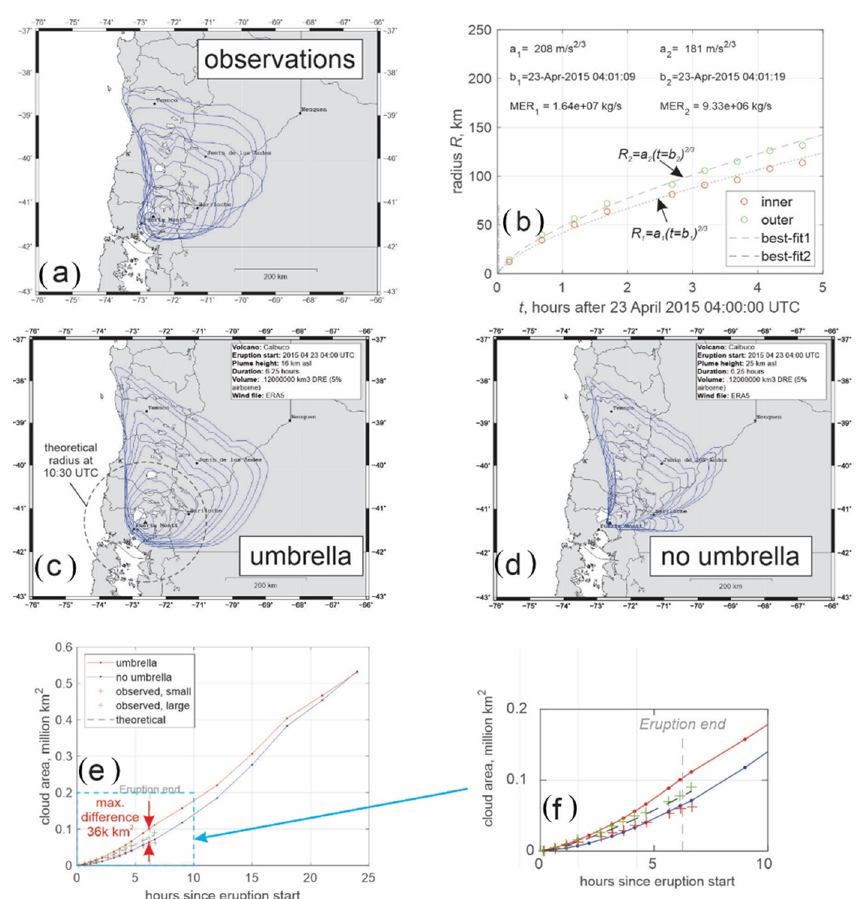
Figure 5. ( a – f ): plots analogous to those of Figure 4a–f, but for phase 2 of the Calbuco eruption. The blue cloud outlines in ( a , c , d ), were taken from images at 04:08, 04:38, 05:08, 05:38, 06:38, 07:08, 07:38, 08:08, 08:38, 09:38, 10:08, and 10:38 UTC on 23 April 2015. In ( a ), only the larger cloud outlines are shown.